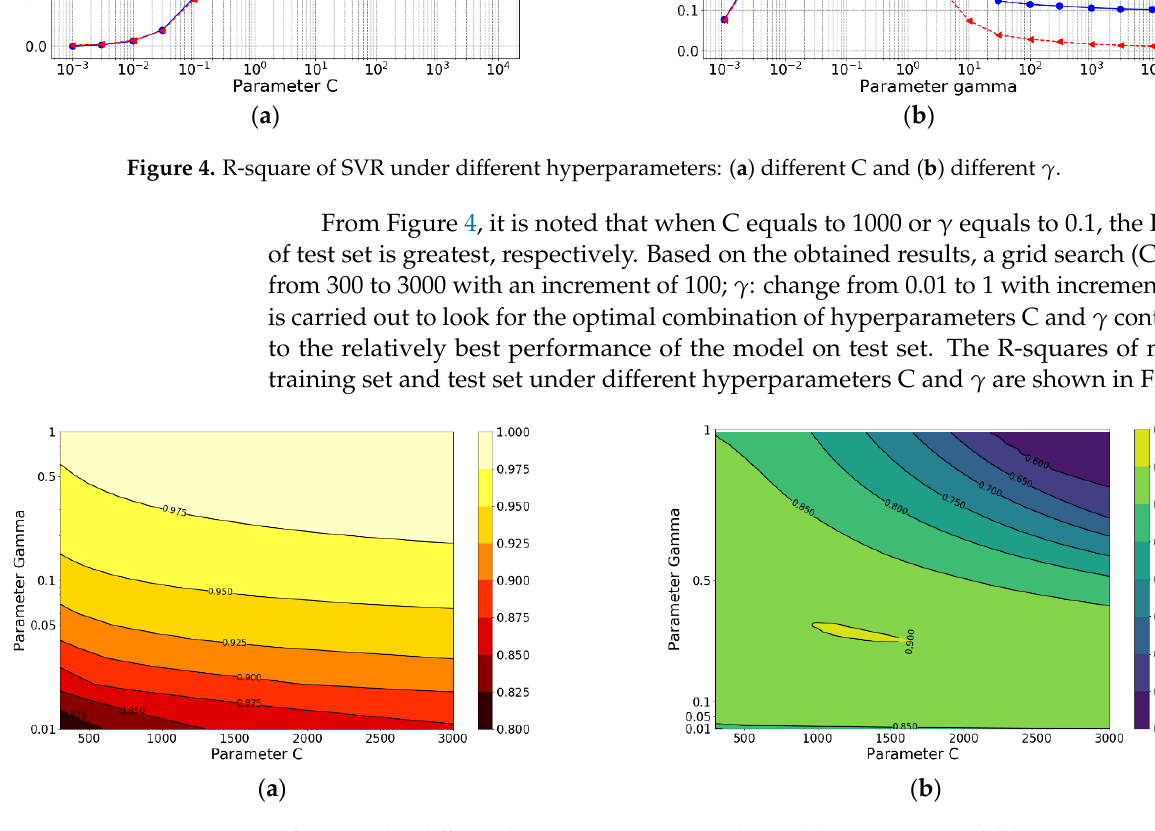
( b ) Figure 6. Prediction accuracy of SVR model on ( a ) training set and ( b ) test set. 3.2.3. Extreme Gradient Boosting (XGBoost) Although the performance of SVR model is better than the LR model, the prediction accuracy still has large space for improvement. Therefore, XGBoost, an ensemble method, is utilized to perform the regression. Before carrying out the prediction with XGBoost, we first import XGB model from the XGBoost package [48]. AS XGBoost is a scalable machine learning system for tree boosting, a lot of hyperparameters can be tuned. In this work, we only tune two hyperparameters: n_estimators and learning rate (shrinkage). The hyperpa- rameter n_estimators represents the number of the base estimators and learning rate scales the contribution of each tree. The reason for choosing those two hyperparameters is that they have a relatively large influence on the state of the model compared to other hyperparameters.